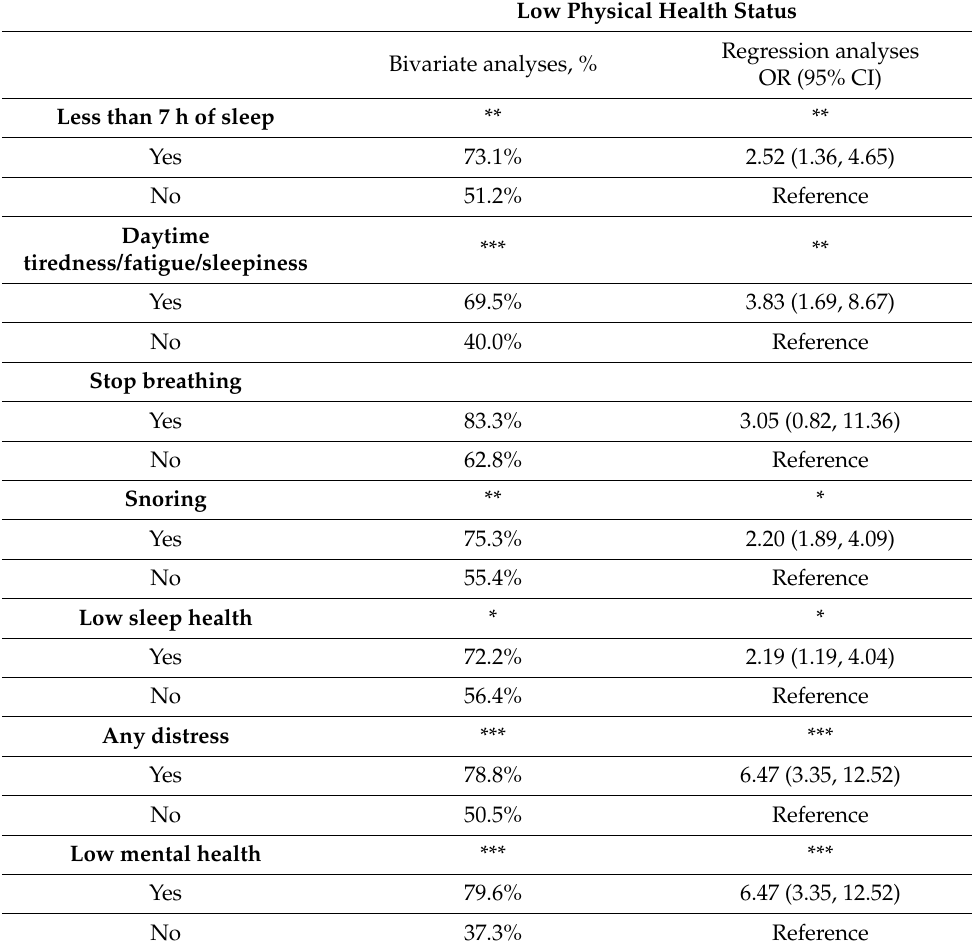
Table 4. Bivariate and adjusted associations between sleep health characteristics and physical health